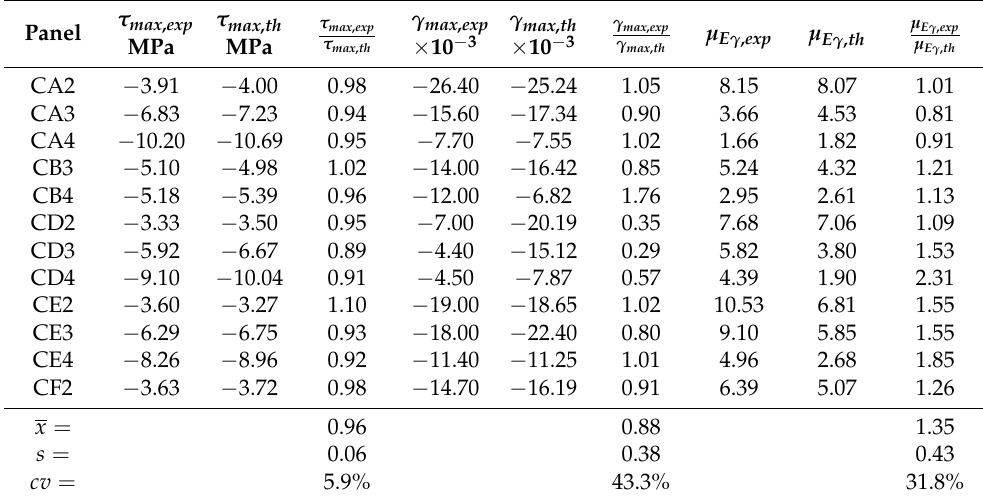
Table 5. Comparative analysis: negative ( − ) loading shear direction (peak point and ductility). τ max , exp Panel